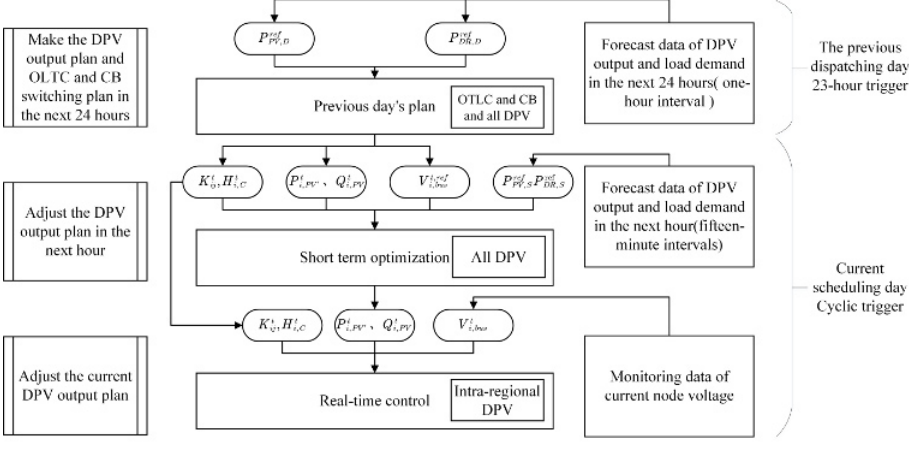
Fig. 1. Voltage classification control flow